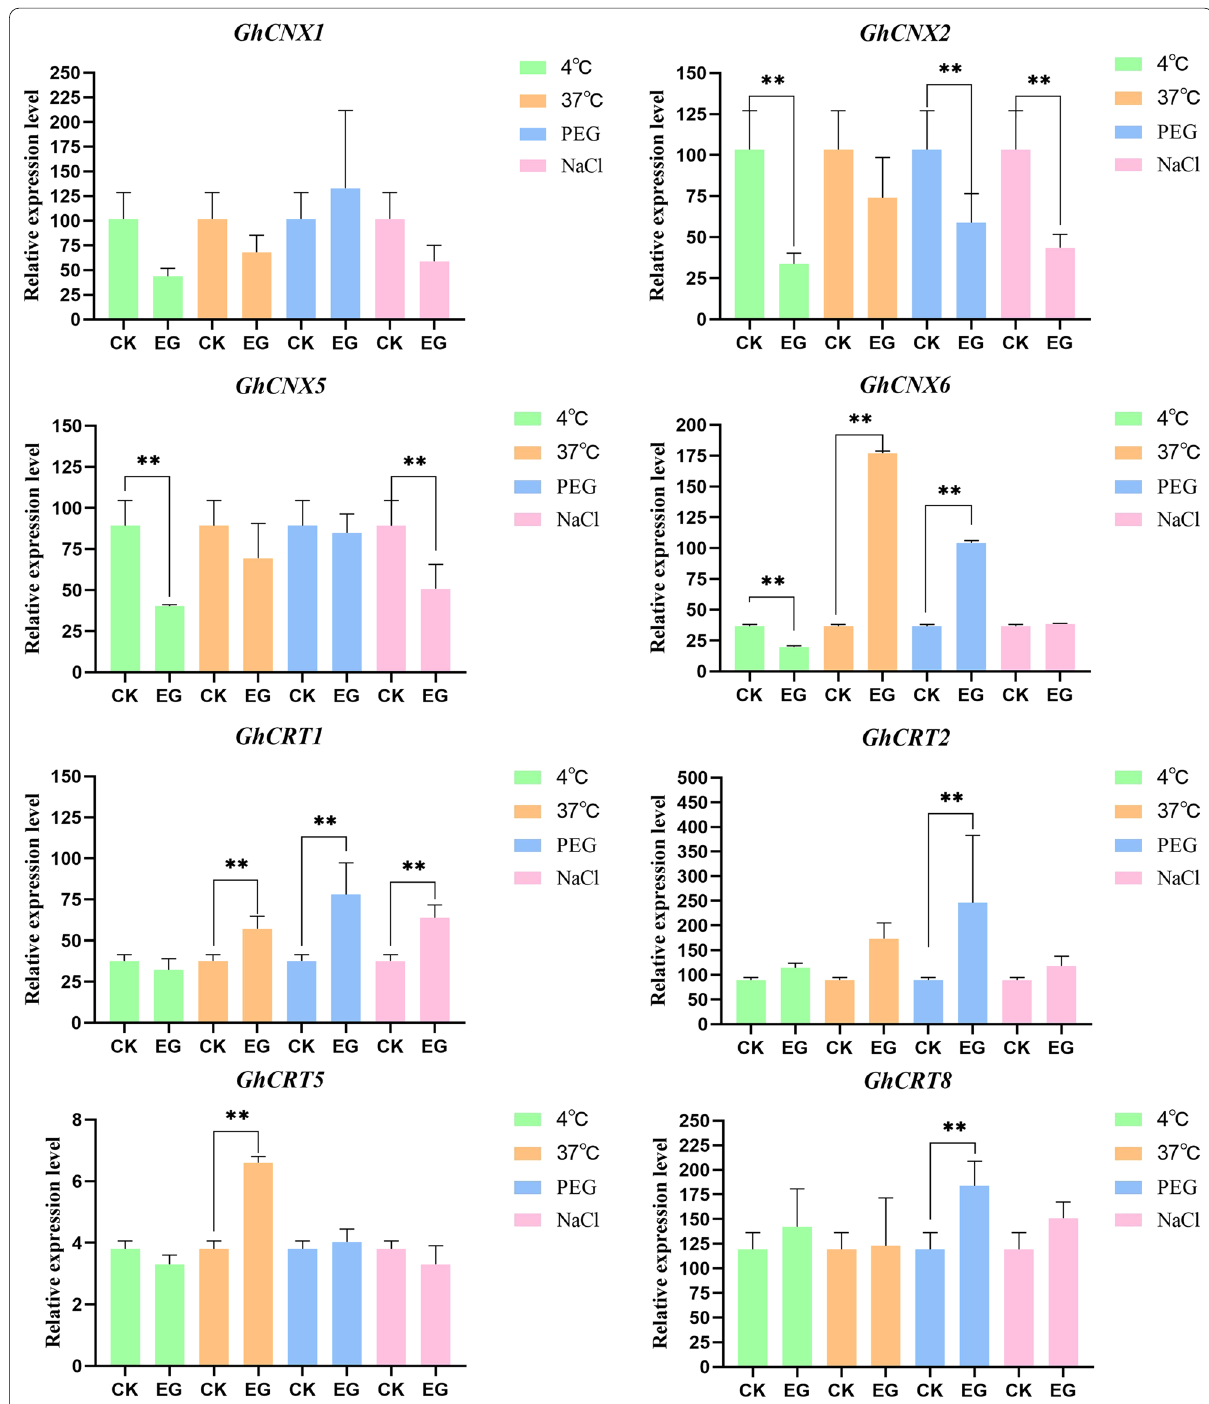
Fig. 8 The different expression patterns of GhCNX family members in G. hirsutum under stress. The leaf expression data of GhCNX family member genes under abiotic stress were obtained from Gossypium Resource And Network Database. The green bar graph shows the relative expression level of CNX family genes under 4 ℃ . The orange bar graph shows the relative expression level of CNX family genes under 37 ℃ . The blue bar graph represents the relative expression level of CNX family genes under PEG. The pink bar graph shows the relative expression level of CNX family genes under NaCl stress. CK was the control group; EG stands for experimental group. ** P < 0.01; The resulting values are expressed in relative units. The error bar in the figure is the standard deviation (SD) of the three biological replicates in each treatment